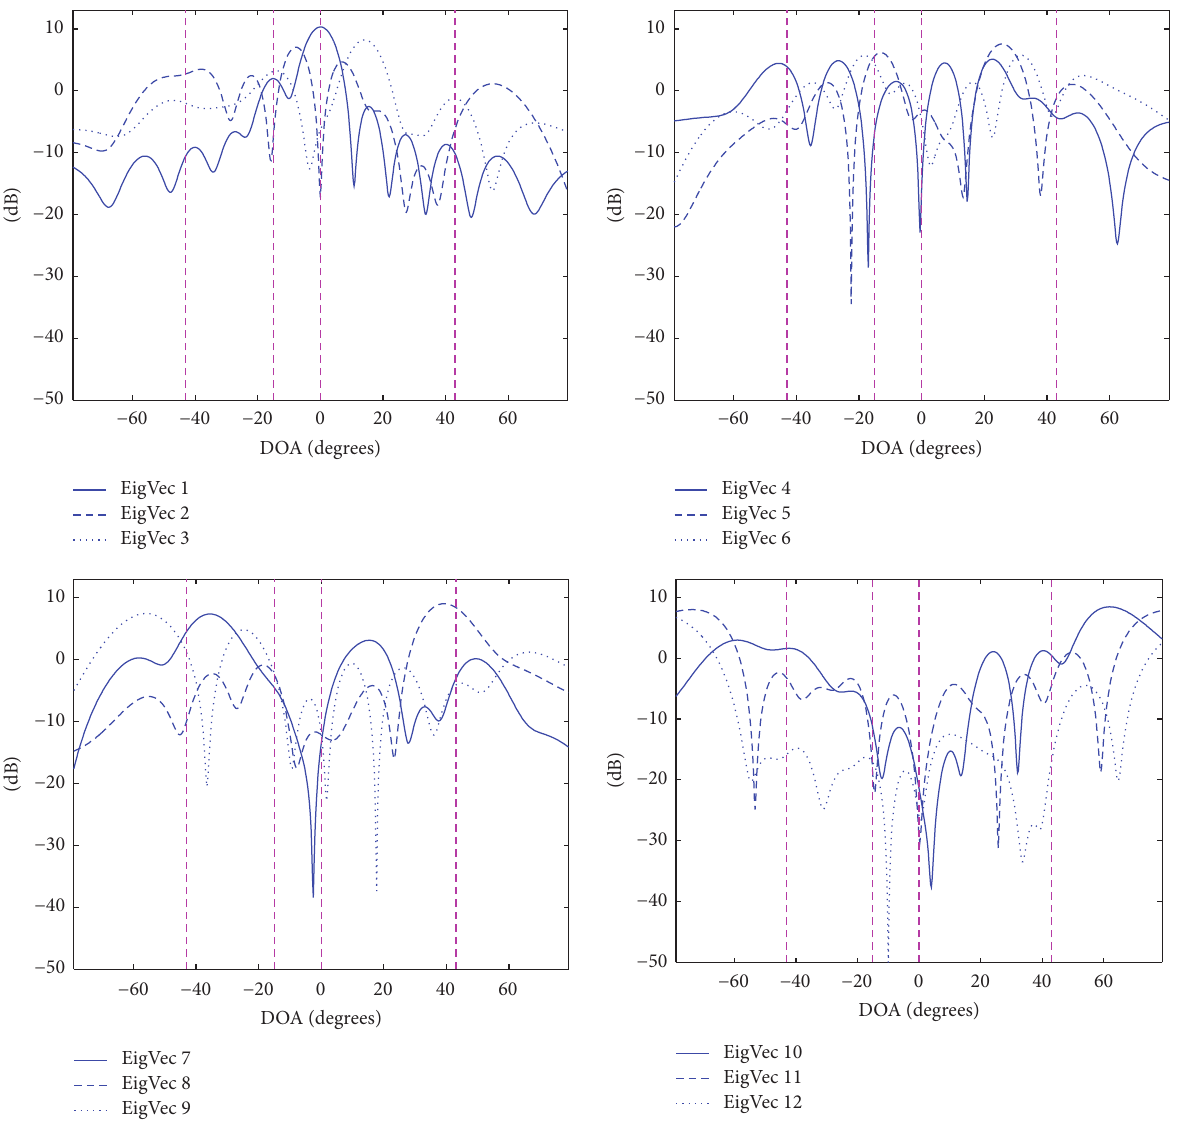
Figure 15: Eigenpatterns for measurement C2SS (two coherent strong transmitters). 1 SM. Dashed vertical lines are the true DOAs of the transmitter(s) and the nearest left and right corner of the reflector. Figure 6.32 in